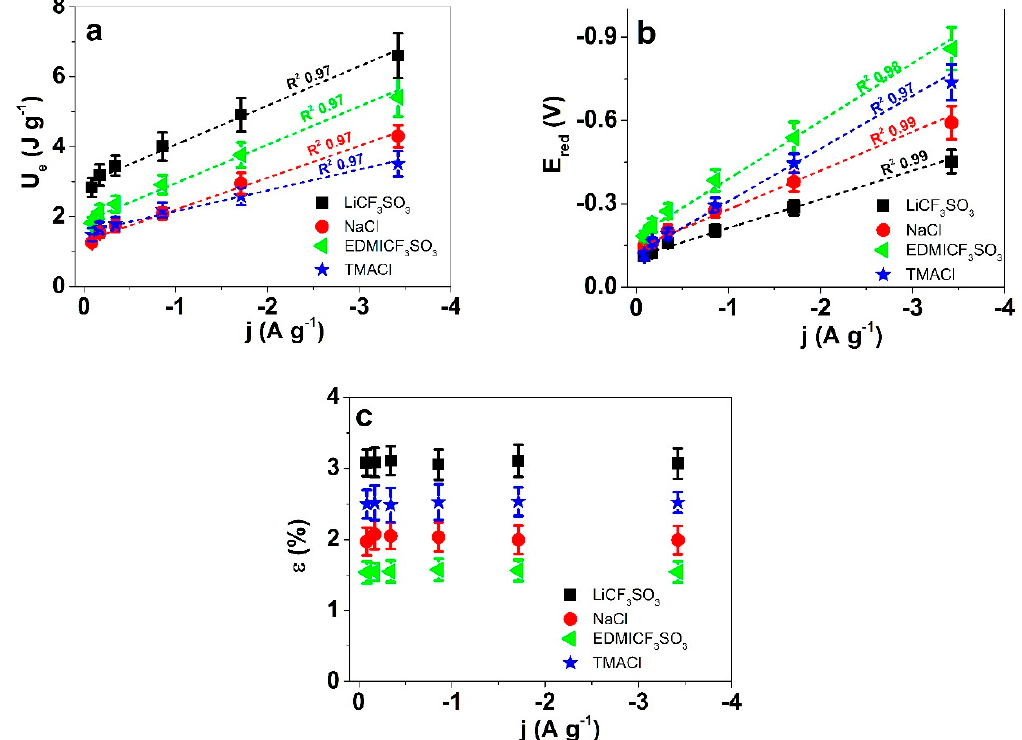
Figure 6. Chronoamperometry of PPy-PEO/DBS linear films in various aqueous electrolytes LiCF 3 SO 3 ( ■ ), NaCl ( ● ), EDMICF 3 SO 3 ( ◄ ) and TMACl ( ★ ) showing in ( a ): the electrical Energy U e , in ( b ): the potential E red at reduction and in ( c ): the linear strain ε against the current density j (A g − 1 ) at reduction. The dashed lines in ( a ) and ( b ) represents the linear fit with included correlation coefficient R 2 .